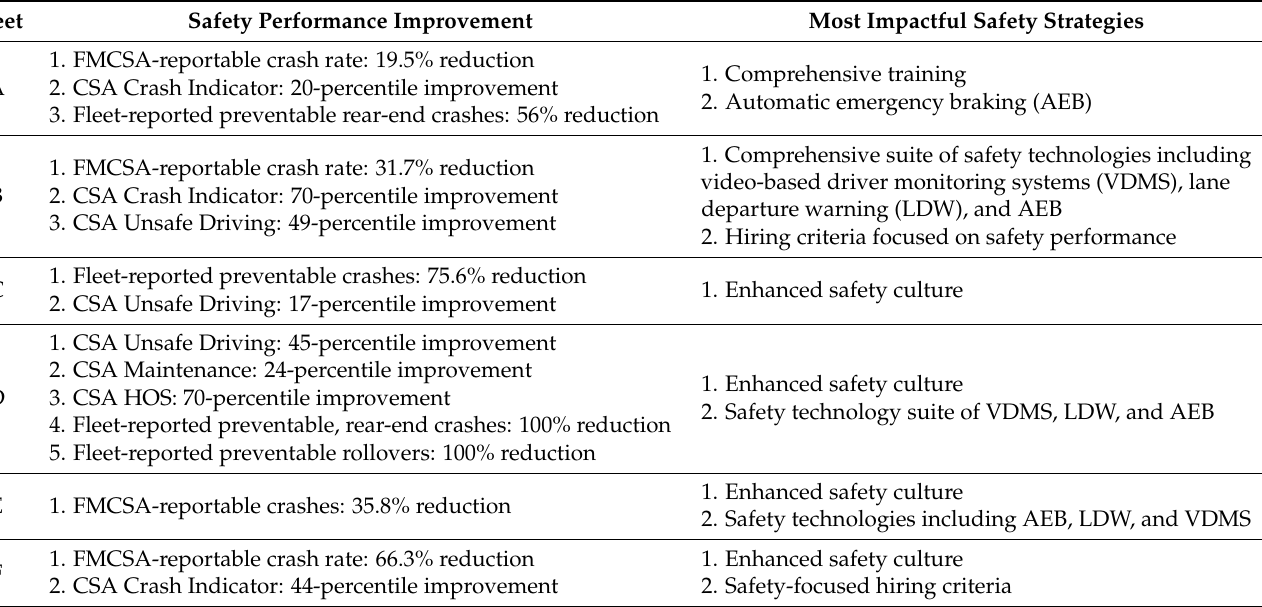
Table 2. Substantial fleet safety improvement